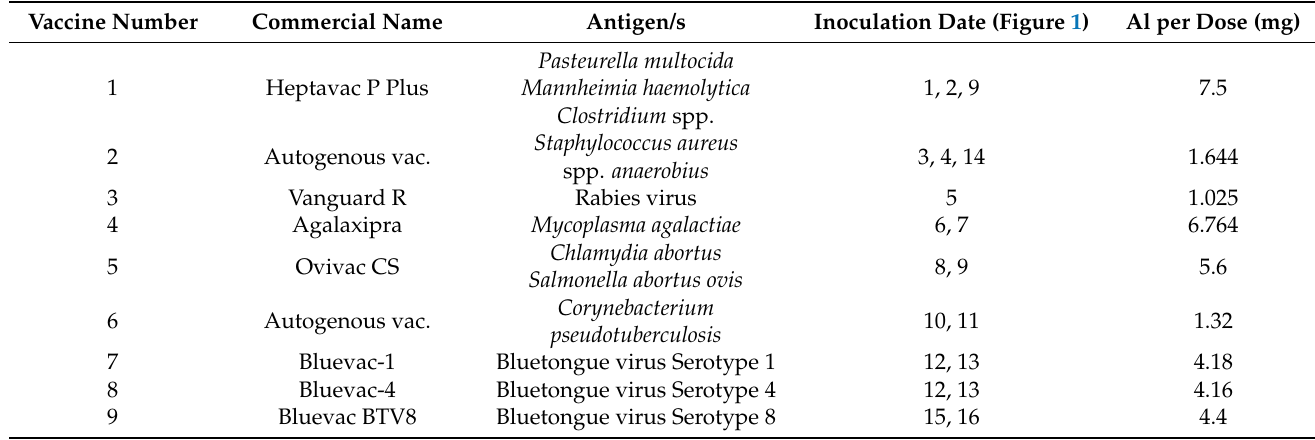
Table A2. Vaccines used in the experiment and inoculation date. Aluminum (Al) content was established by inductively coupled mass spectrometry (ICP-MS) and calculated as milligrams (mg) per total